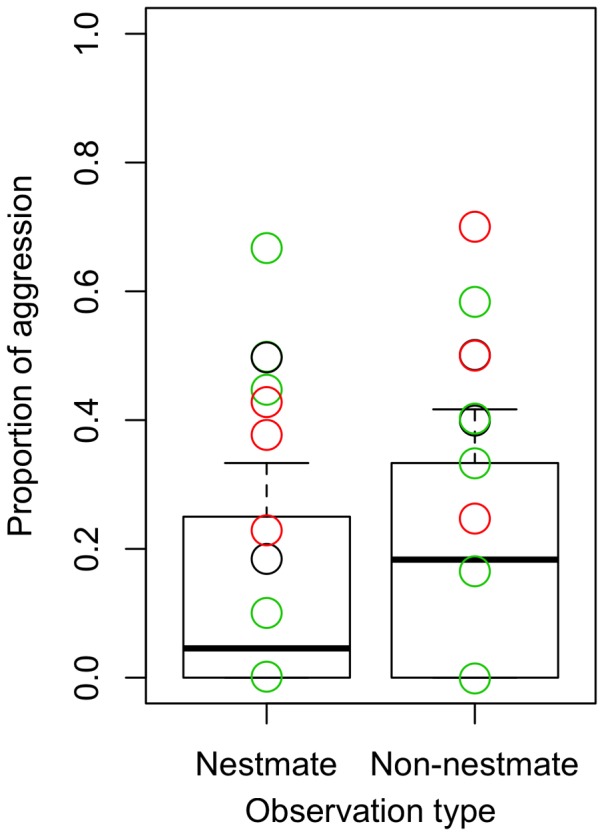
Proportion of aggressive behavior by Ca. femoratus in behavioral assays with nestmate and non-nestmate Cr. levior ants.Black circles are within Cr. levior Type B, green circles are within Cr. levior Type B, and red circles are for between Cr. levior Type A and Cr. levior Type B colony pairs. There was not a significant difference in aggression towards non-nestmates.